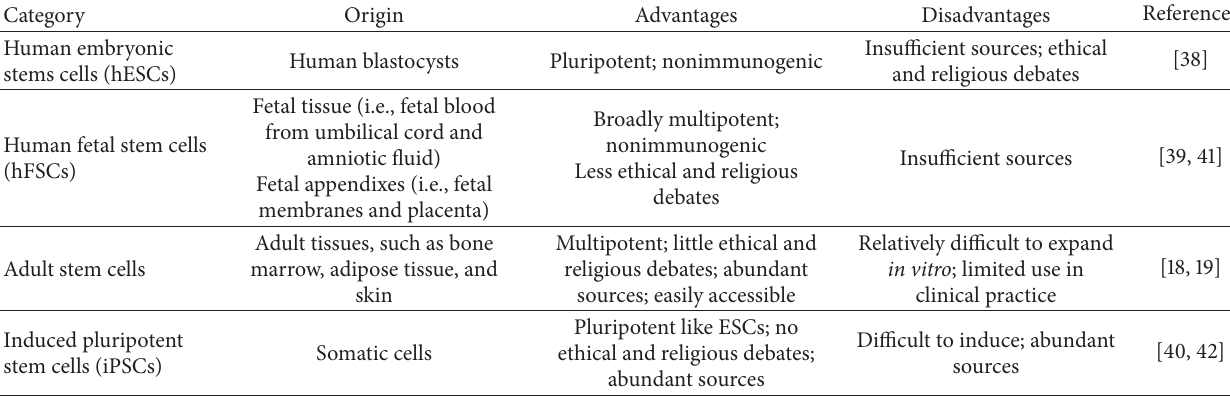
Table 1: Characteristics of different stem